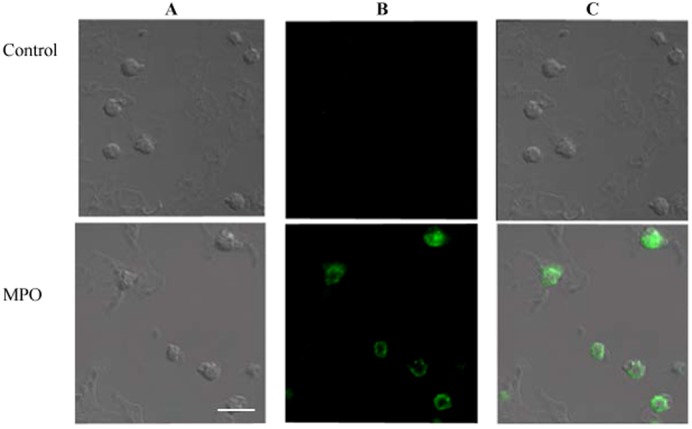
Confocal images showing MPO binding to platelet plasma membrane.Washed human platelets (2×107 cells/ml) were incubated alone (upper section) or with MPO (100 nM) (lower section) for 10 minutes at 37°C, fixed with 4% paraformaldehyde and stained for MPO with an anti-MPO antibody and anti-rat IgG-FITC as described in Materials and Methods. (A) Transmission light microscopy. (B) Fluorescence microscopy of the same cells in panel A. (C) Merged images from panels A and B. Scale bar: 5 µm. The micrographs shown are representative of three separate experiments.